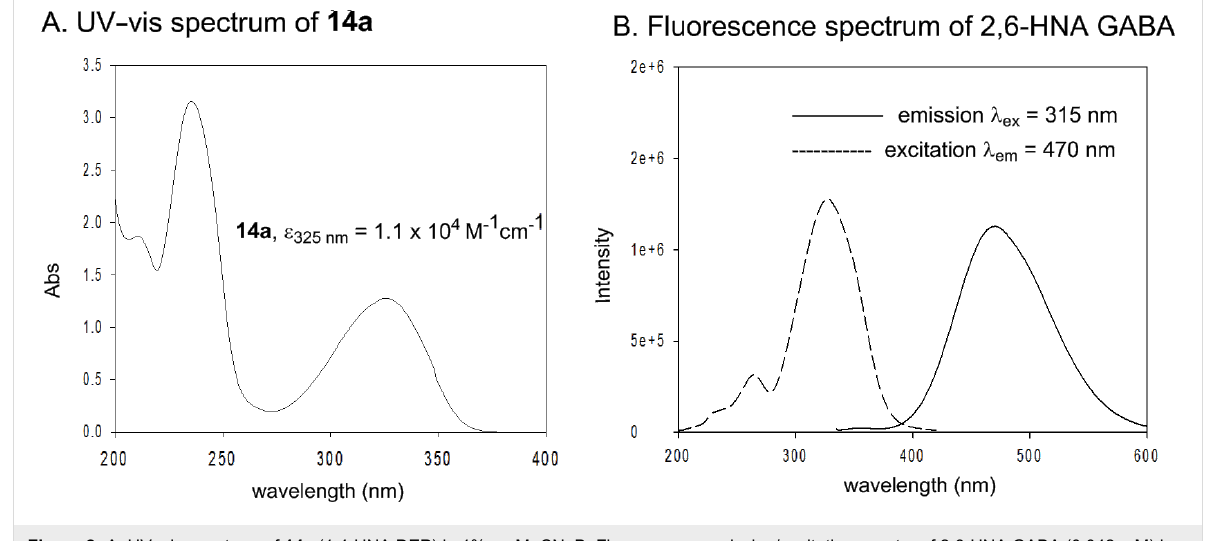
Figure 2: A. UV–vis spectrum of 14a (1,4-HNA DEP) in 1% aq MeCN. B. Fluorescence emission/excitation spectra of 2,6-HNA GABA (0.042 mM) in pH 7.3 TRIS buffer containing 1% MeCN.